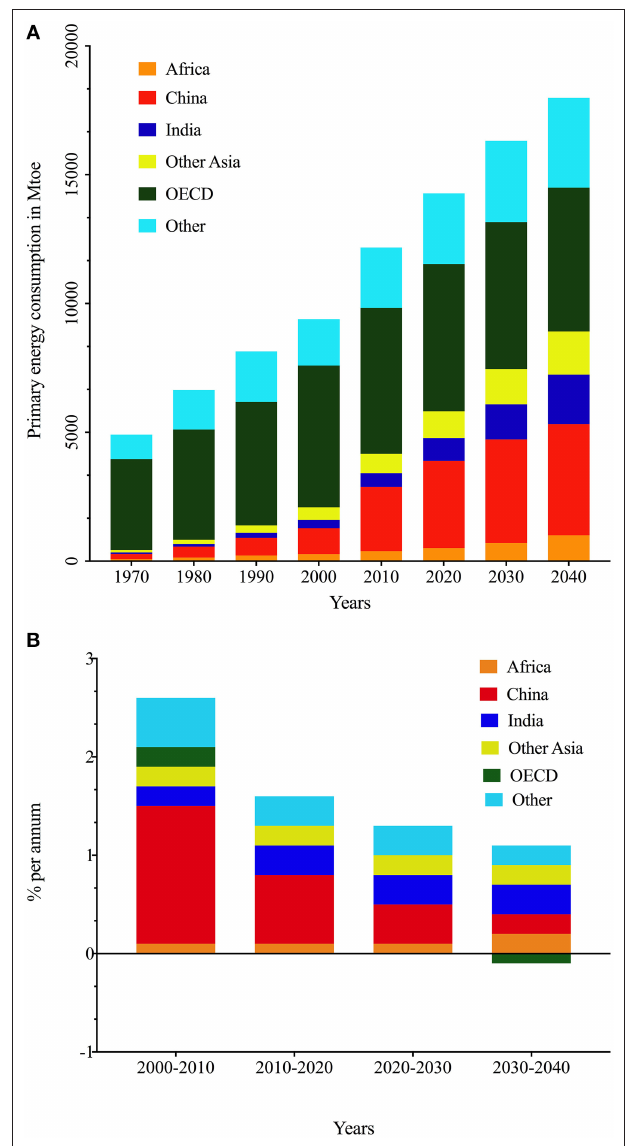
FIGURE 3 | (A) Primary energy consumption by region. Data Source: BP Energy Outlook 2018 (United Nations, 2017). (B) Percentage growth by regional contributors. Data Source: BP Energy Outlook 2018 (United Nations,